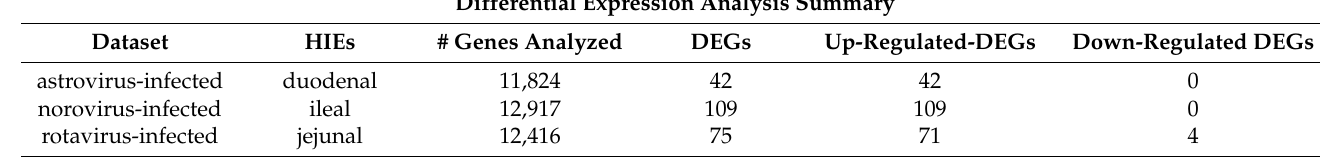
Table 1. Differential expression analysis summary. Differential analysis of RNA-seq data was performed on the three published RNA-seq datasets. Listed are the total number non-weakly expressed genes that were analyzed in each dataset to determine differentially expressed genes (DEG).